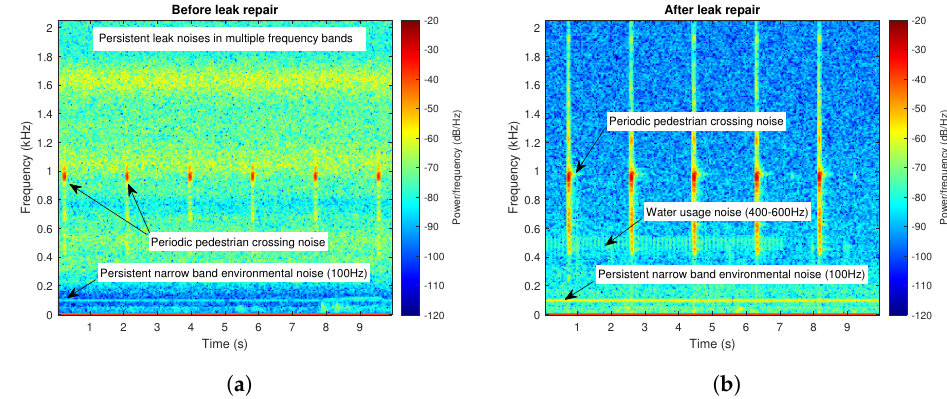
Figure 4. Spectrograms for a sensor detecting a variety of noises: ( a ) before and ( b ) after a leak was repaired ∼ 21 m away from the sensor. The sensor was situated <1 m from a pedestrian